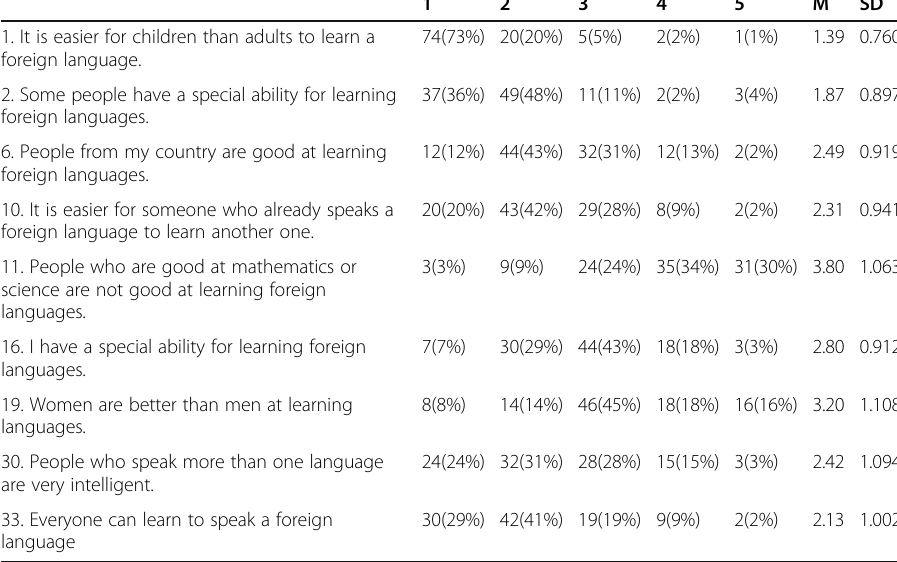
Table 2 Frequency of Participant Response to BALLI items on Foreign Language Aptitude 1